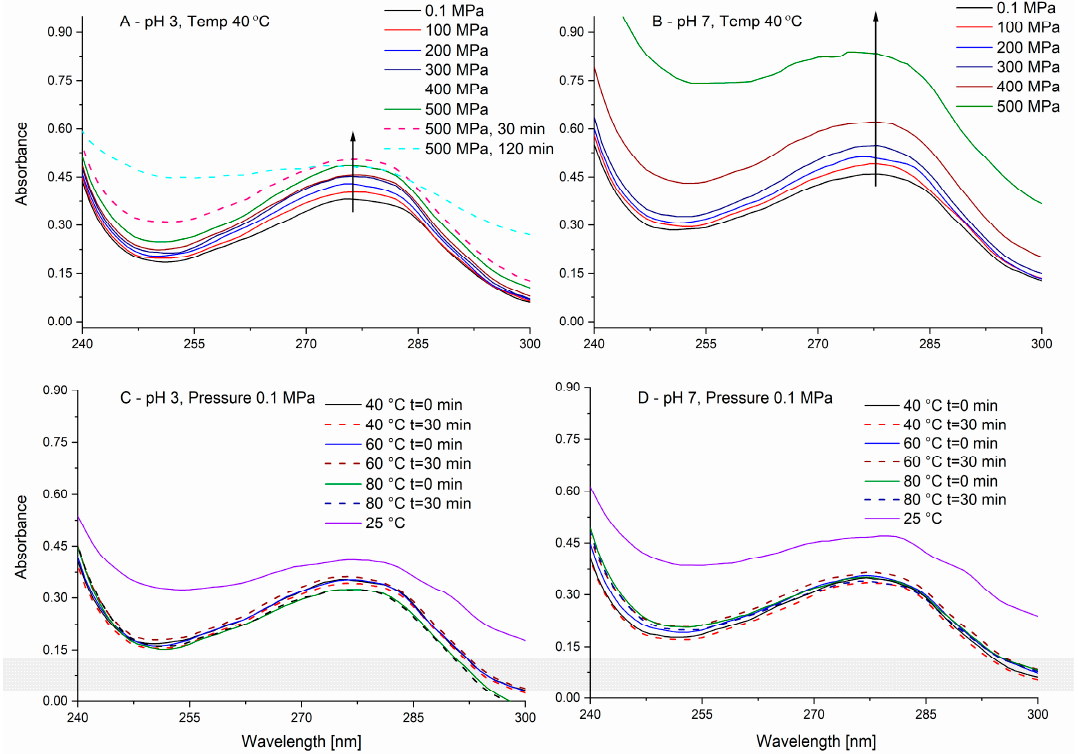
Figure 3. Averaged UV absorbance of potato protein isolate (PPI) (0.05% w / w ) during pressure ( A , B ) and thermal ( C , D ) treatments at pH 3 ( A , C ) and pH 7 ( B , D ). Full lines represent the absorbance immediately after pressure or temperature increase, while the dashed lines represent the absorbance after different times as described in the legend. The arrows are to guide the eye for changes occurring with increasing pressure.